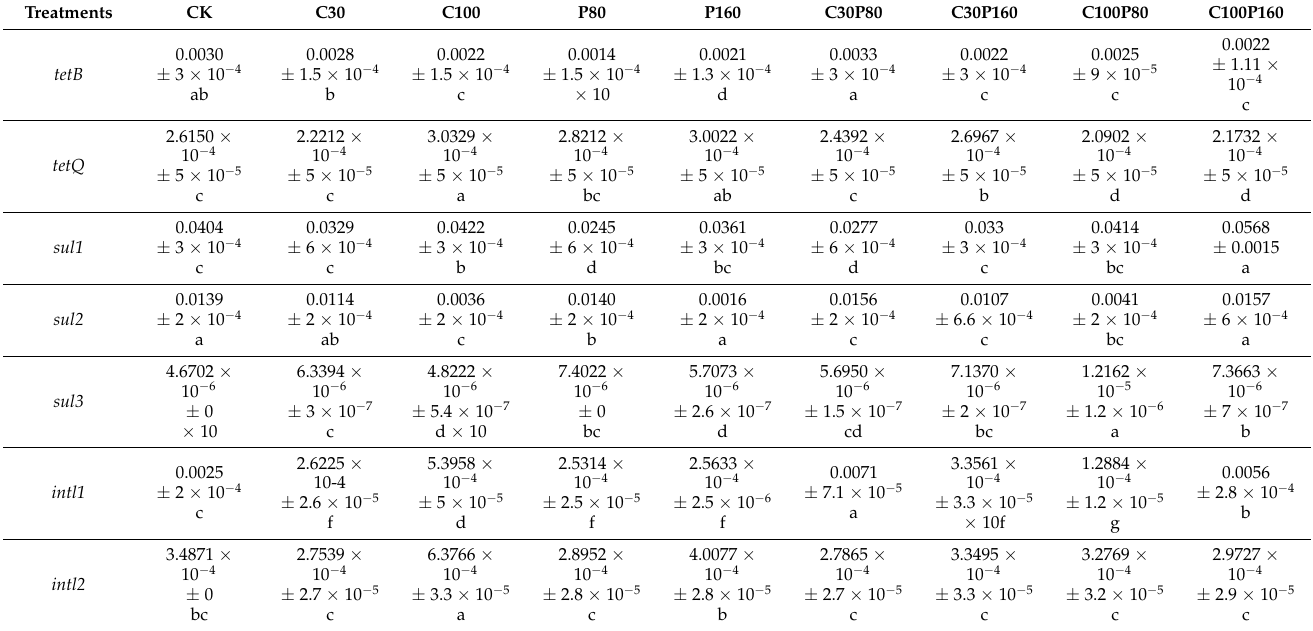
Table 4. Relative abundance of ARGs of samples from different treatment